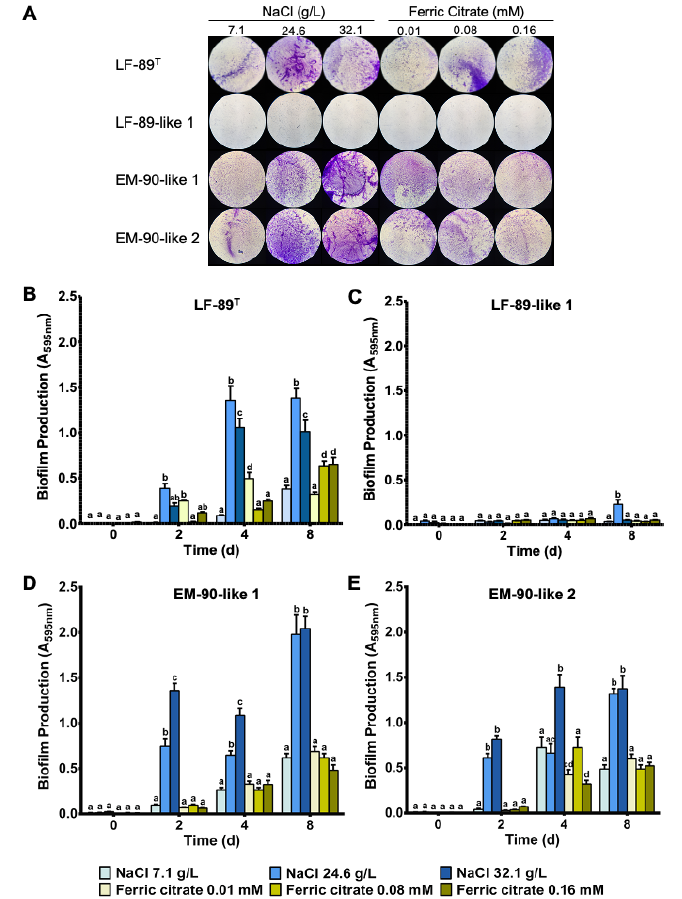
Figure 1. P. salmonis biofilm formation cultured under different NaCl and ferric citrate concentrations. ( A ) Representative CV staining of biofilm produced by P. salmonis LF-89 type strain and isolates LF-89-like 1, EM-90-like 1, and EM-like 2 at eight days (100 × magnification). Biofilm quantification for P. salmonis LF-89 ( B ) and isolates LF-89-like 1 ( C ), EM-90-like 1 ( D ), and EM-90-like 2 ( E ) grown for 0,